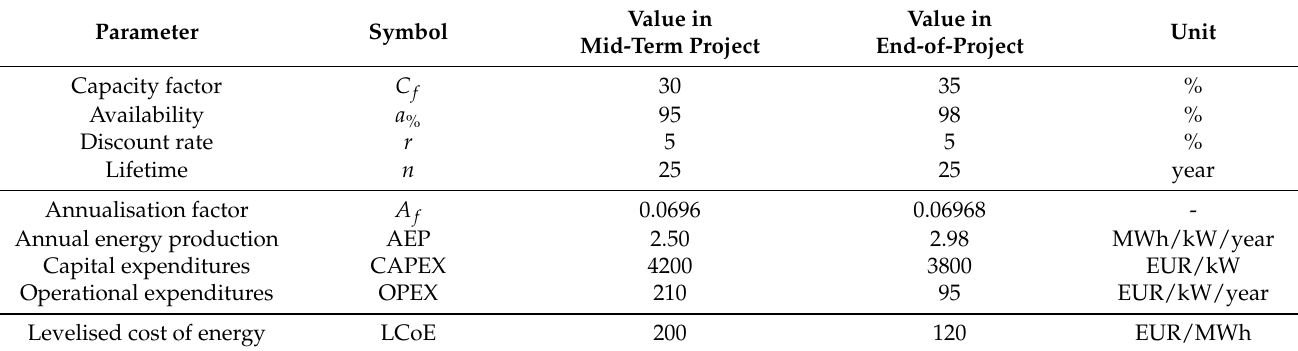
Table 5. A summary of the parameters of the two LCoE targets along the